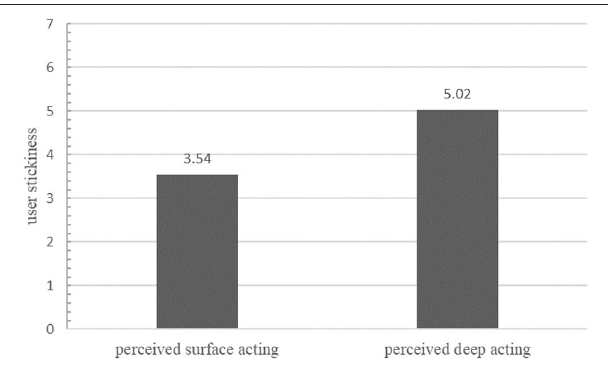
FIGURE 2 | Comparison of differences in user stickiness under differently perceived emotional